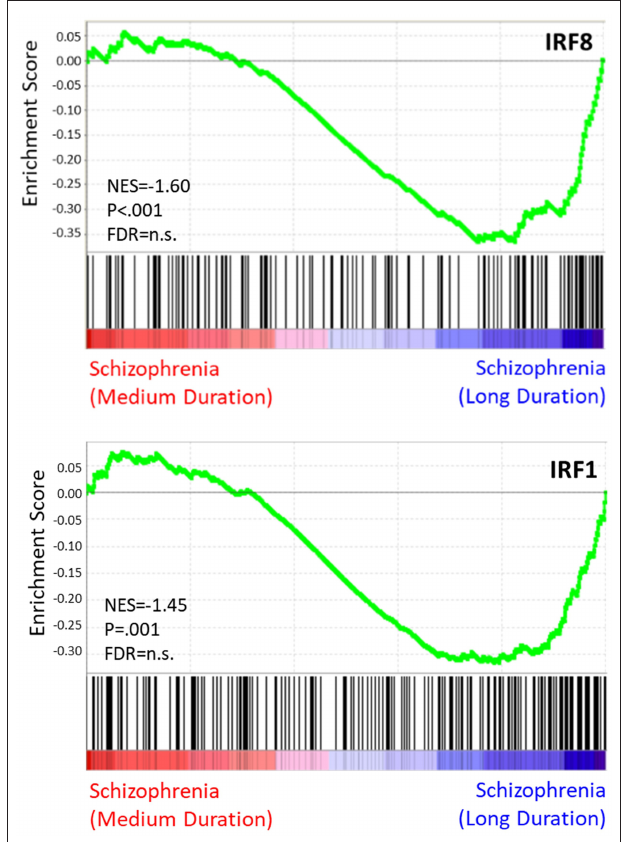
FIGURE 6 | TF enrichment plots: medium vs. long illness duration. Genes are ranked from greatest increase to the greatest decreased in expression in the long illness duration group compared to controls. Black lines indicate the location of genes that are in both the ranked list and gene set